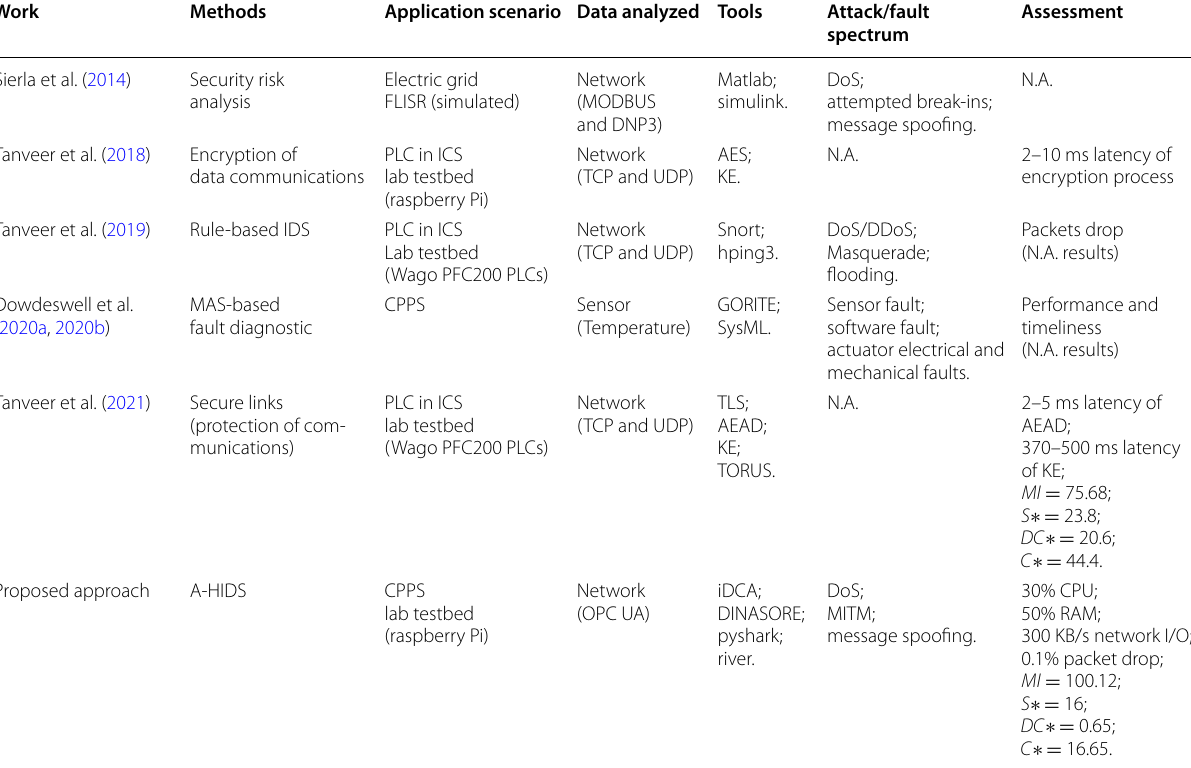
Table 1 Summary of IEC 61499-based security